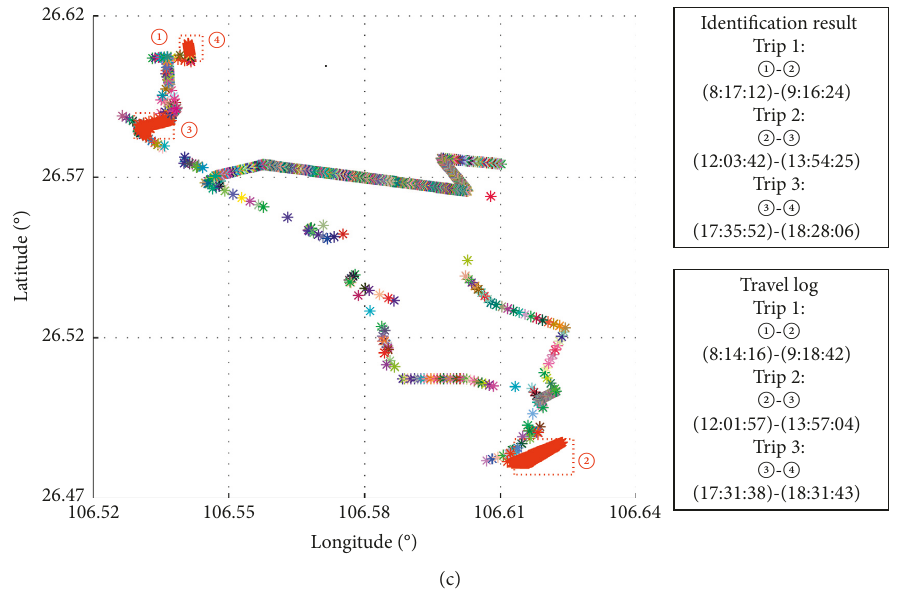
Figure 14: An example of trip end identification results from three perspectives. (a) Spatiotemporal perspective: from north to south. (b) Spatiotemporal perspective: from west to east. (c) Spatial